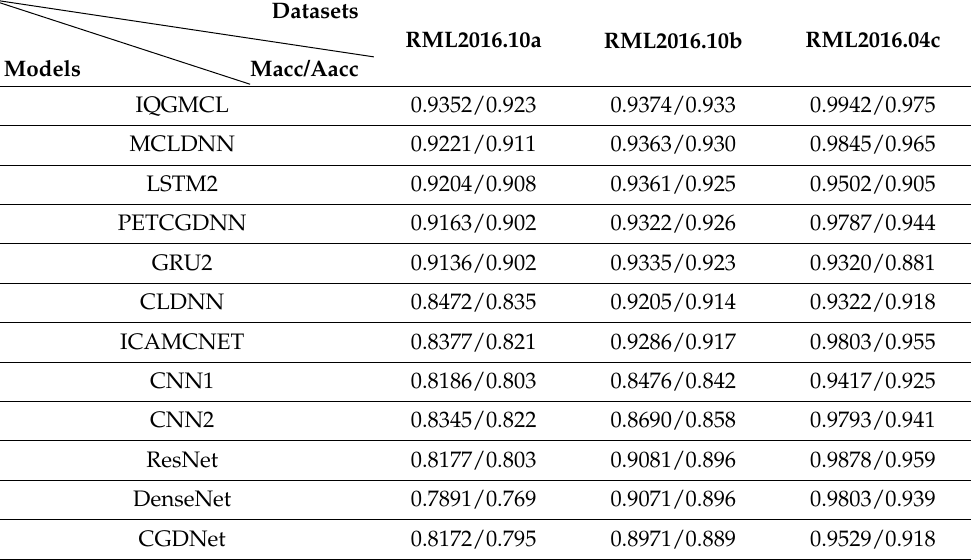
Table 3. Macc and Aacc for each network.